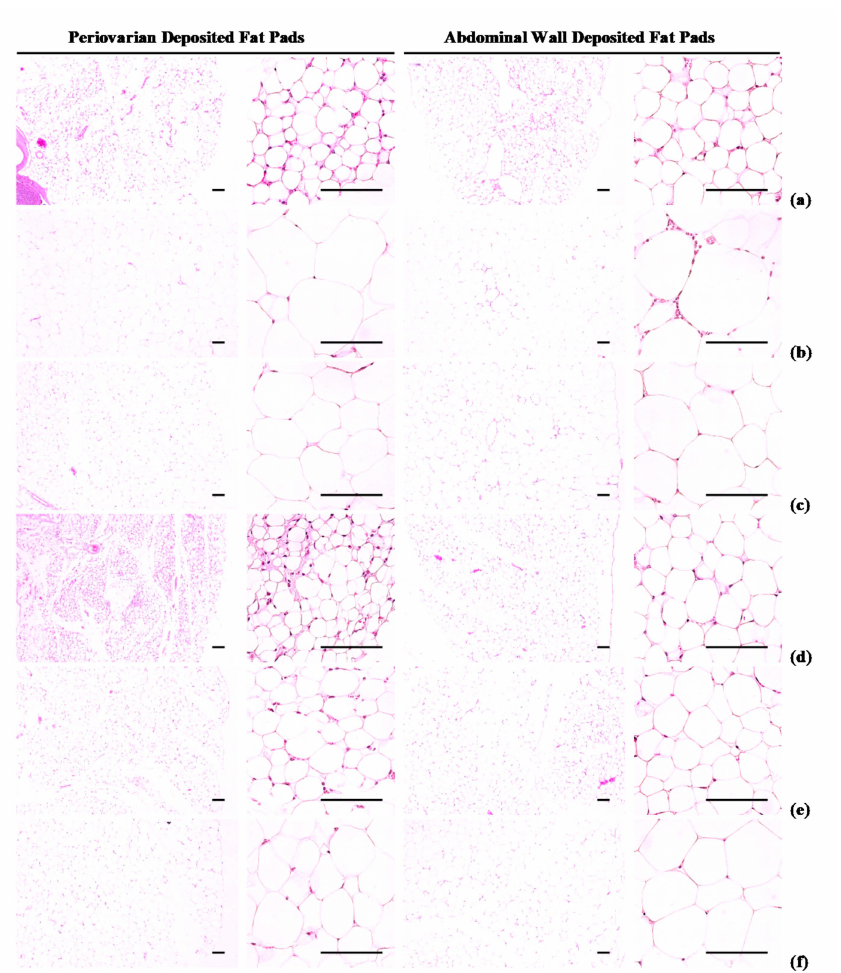
Figure 4. Representative histological images of the adipocytes, taken from NFD or HFD supplied mice periovarian and abdominal wall deposited fat pads. ( a ) Vehicle (distilled water) 10 mL / kg orally administered mice with NFD supply (Intact control); ( b ) Vehicle 10 mL / kg orally administered mice with HFD supply (HFD control); ( c ) 250 mg / kg of metformin oral administered mice with HFD supply (Metformin); ( d ) WL 200 mg / kg orally administered mice with HFD supply (WL200); ( e ) WL 100 mg / kg orally administered mice with HFD supply (WL100); ( f ) WL 50 mg / kg orally administered mice with HFD supply (WL50). NFD = Normal pellet diet; HFD = 45% Kcal high-fat diet; WL = Wasabi Leaf / Folium, Wasabia japonica (Miq.) Matsum extracts. All Hematoxylin & Eosin stain. Scale bars = 80 µ